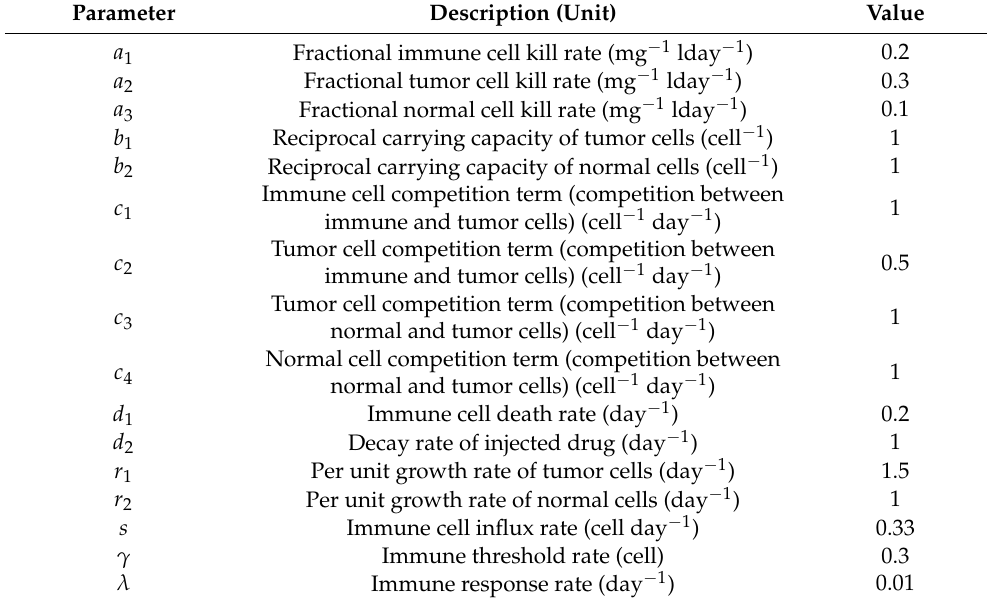
Table 1. The simulated patient’s parameters